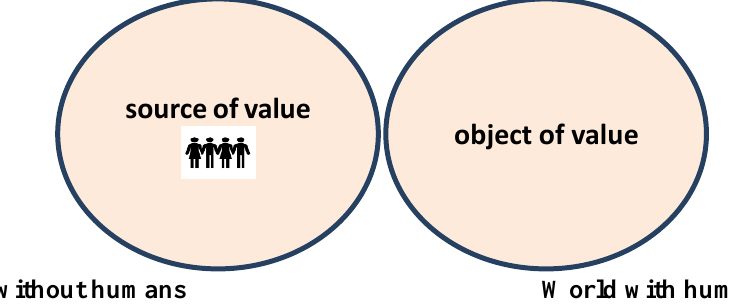
Figure 1. The distinction between the object and the source of